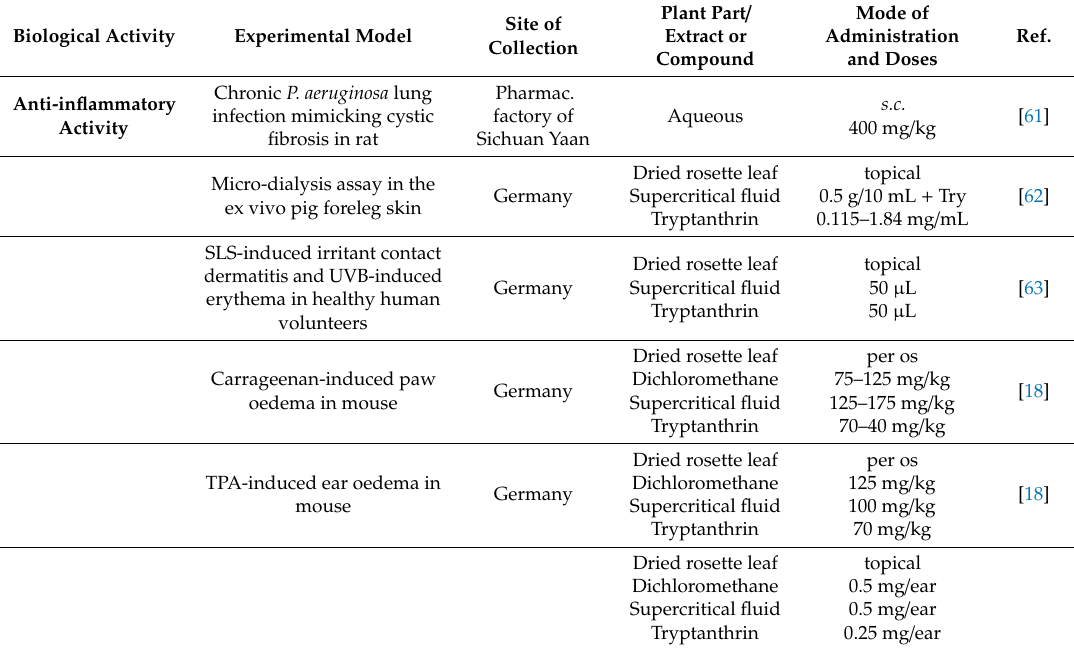
Table 2. Biological activities of extracts and isolated compounds from I. tinctoria